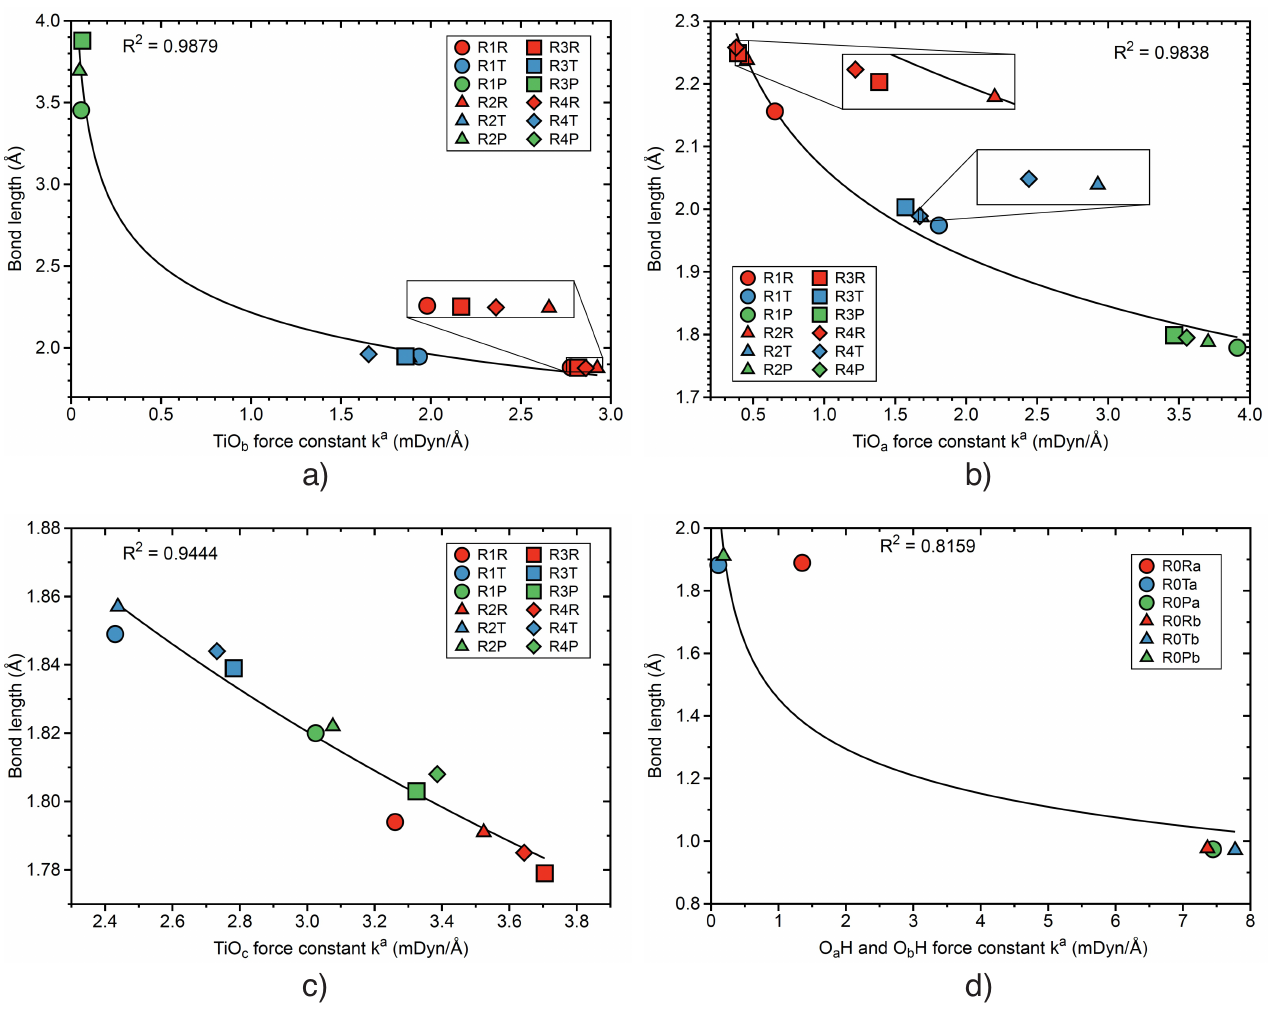
d)c) Figure 14. Correlation between bond lengths and the local mode force constants. ( a – c ) TiO b , TiO